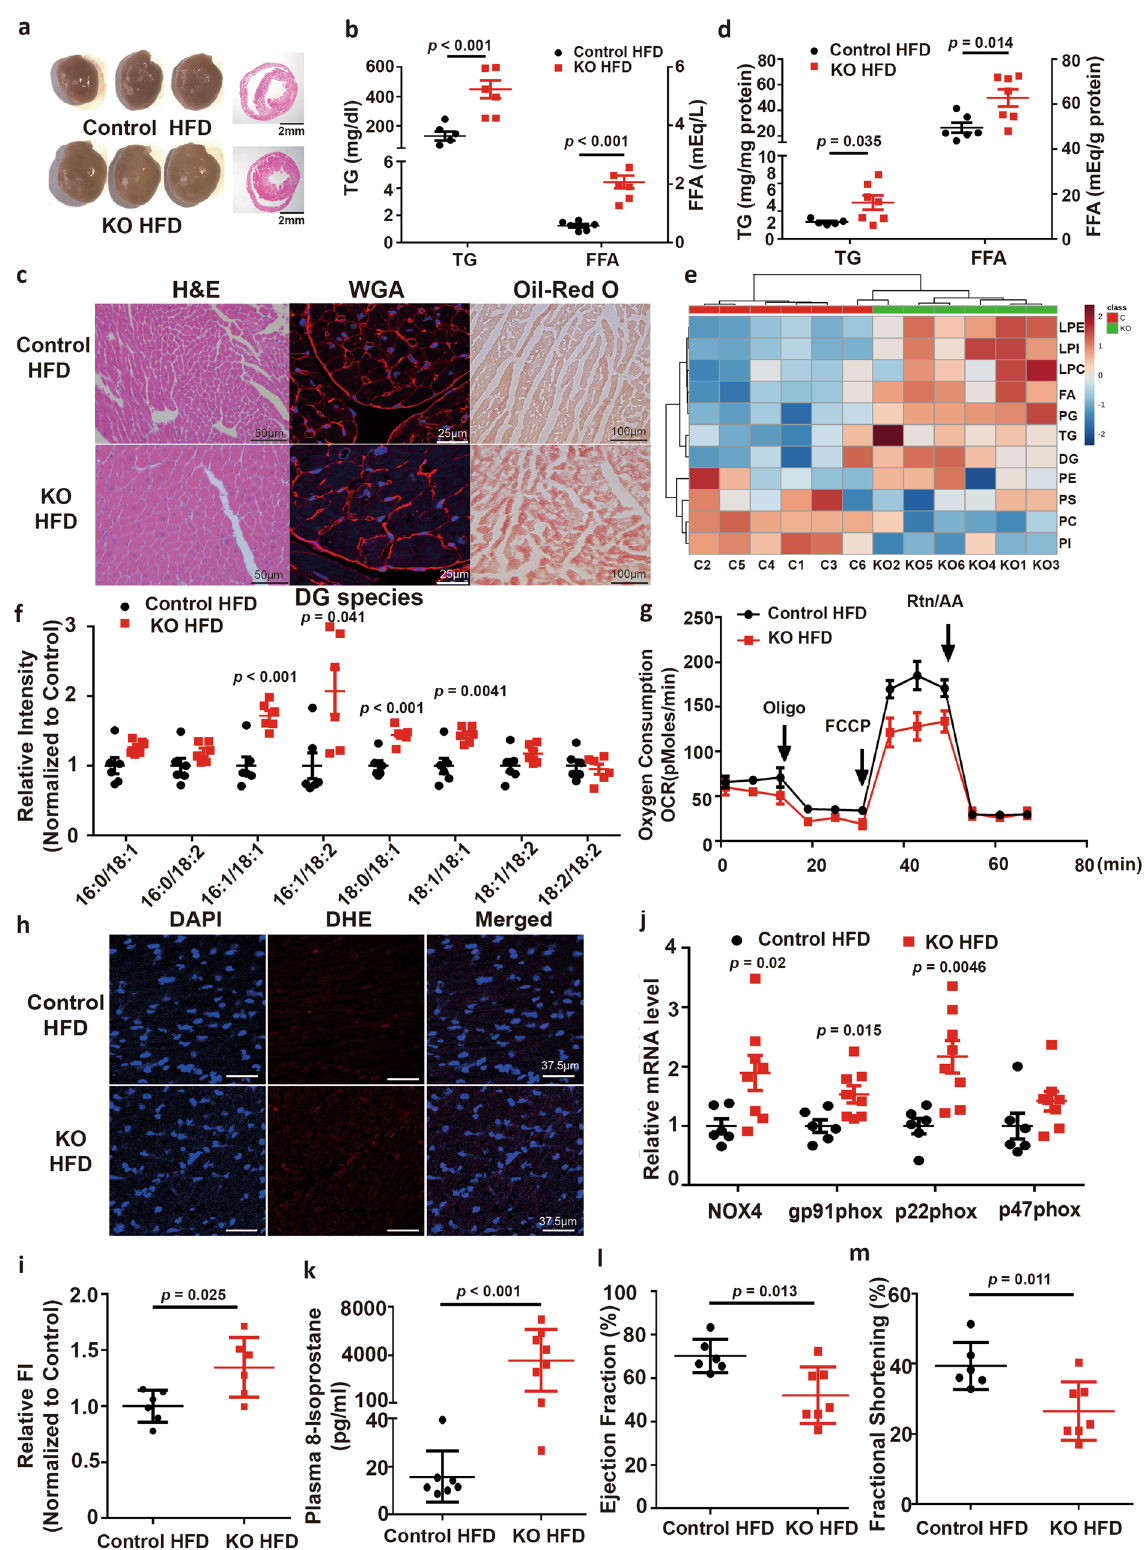
by heart weight/tibia length and TG level (Fig. 6b, c), which become comparable to those in control mice without TMAVA treatment (Fig. 3c vs Fig. 6b). H&E, WGA, and Oil-red O staining revealed abolished hypertrophy of myocardial cells and decreased neutral lipid deposition in the carnitine-treated mice (Fig. 6d). The level of the myocardial TG and FFA in the